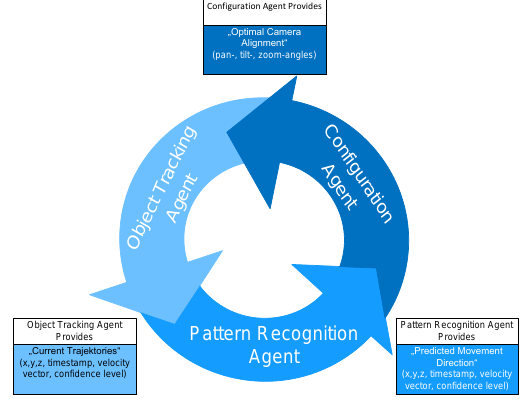
Figure 1: Circle of